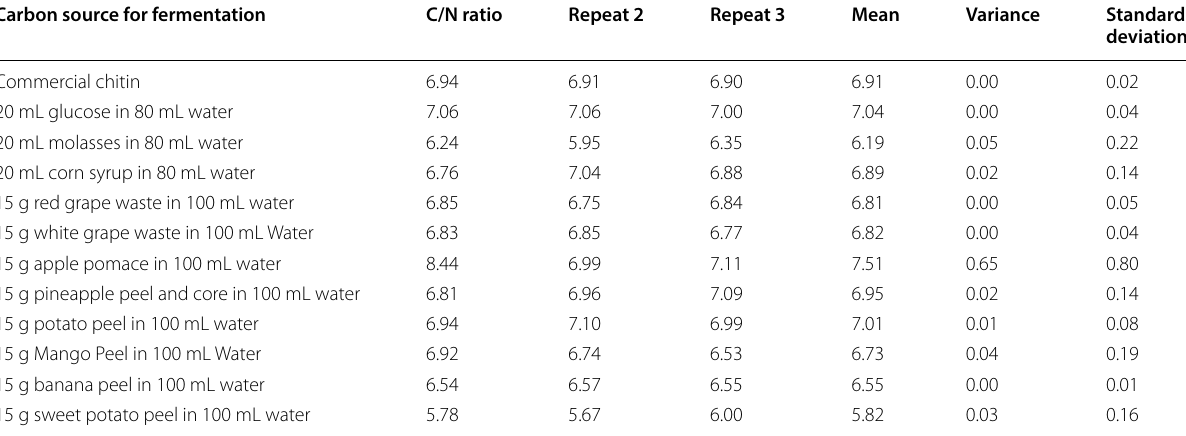
Table 7 Statistical analysis of elemental analysis of commercial chitin and chitin extracted after fermentation on various carbon sources Carbon source for fermentation